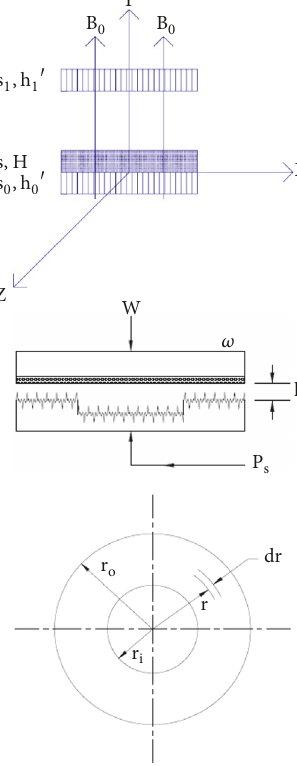
Figure 1: Configuration of bearing